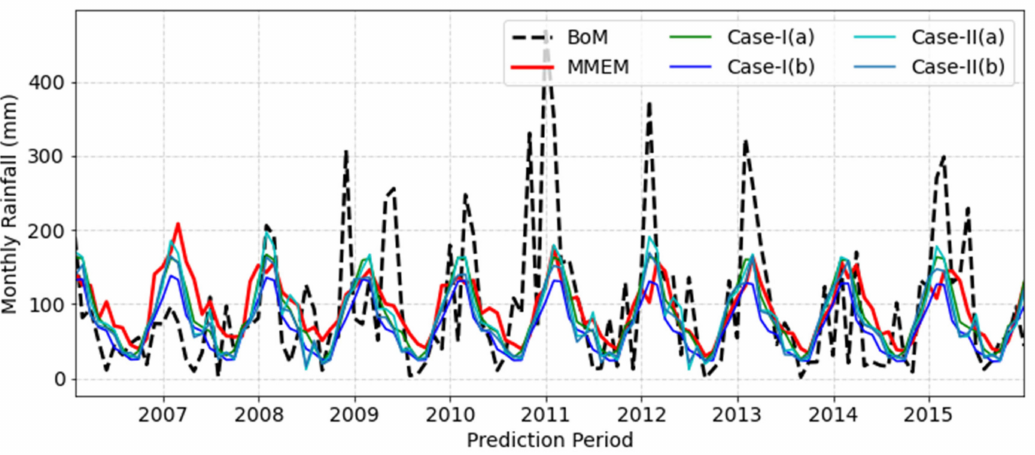
Figure 2. Comparison of FBP-predicted monthly rainfall of different cases with the corresponding observed